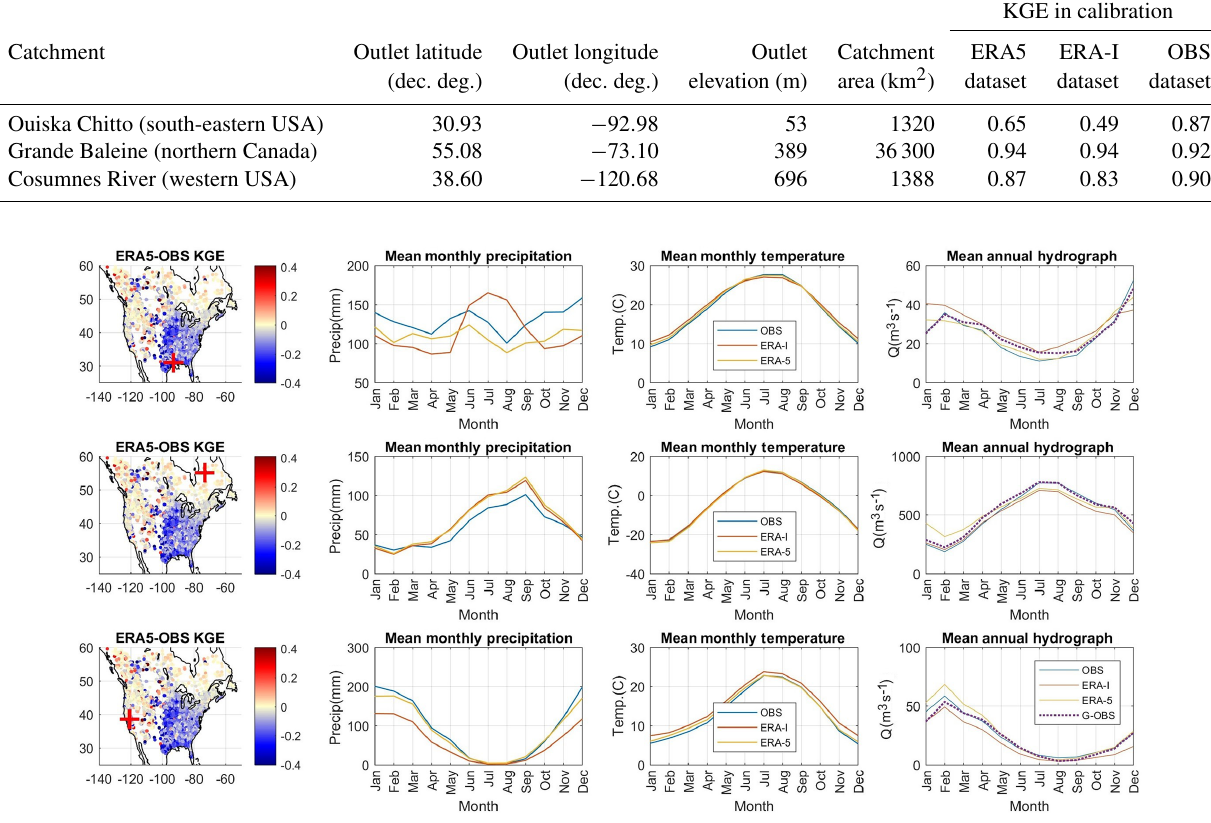
Figure 12. Difference in hydrological modelling performance, mean monthly precipitation and temperature and mean annual hydrograph using ERA-I and ERA5 observations (OBS) and streamflow observations (G-OBS) on three dissimilar catchments: Ouiska Chitto Creek (top row), Grande Rivière à la Baleine (centre row) and Cosumnes River (bottom